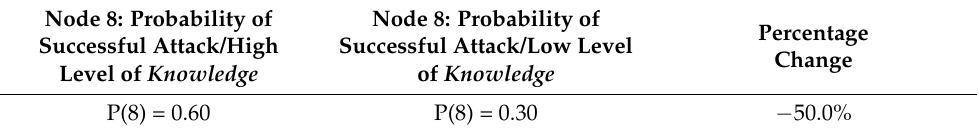
Table 8. Case study sensitivity analysis results for Node 8, considering level of Knowledge. Node 8: Probability of Successful Attack/High Level of Knowledge